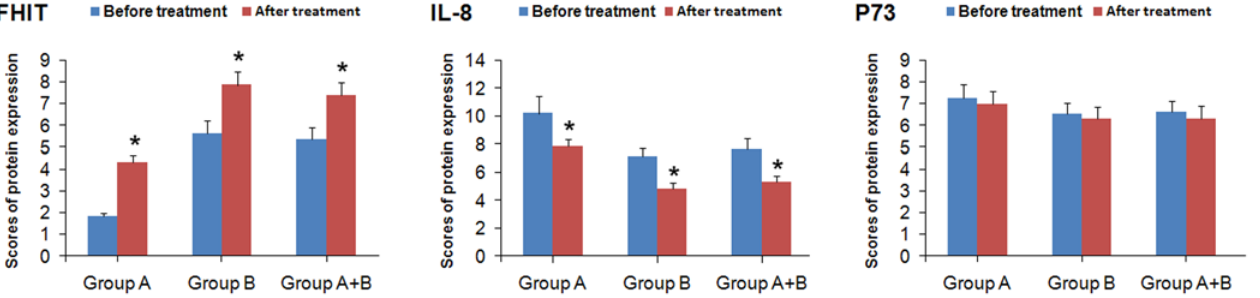
Fig 4. Effect of eradication of H . pylori on protein expression of FHIT, IL-8 and P73. Group A, patients with both H . pylori infection and family histories of gastric cancer. Group B, patients with H . pylori infection and without family histories of gastric cancer. Data were expressed as the mean ± standard deviation. Statistical differences were determined by Wilcoxon rank-sum test. Compared with before treatment, * P < 0.05.